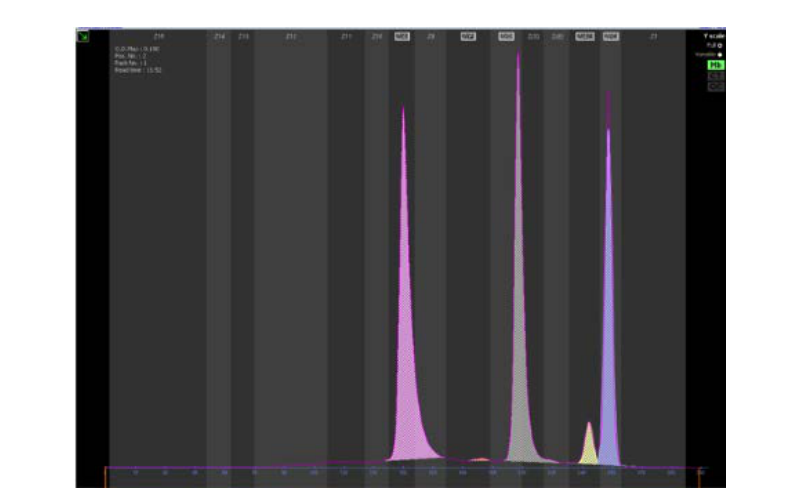
Figure 2. Capillary zone electrophoresis with two predominant peaks in HB D and HB C zone.